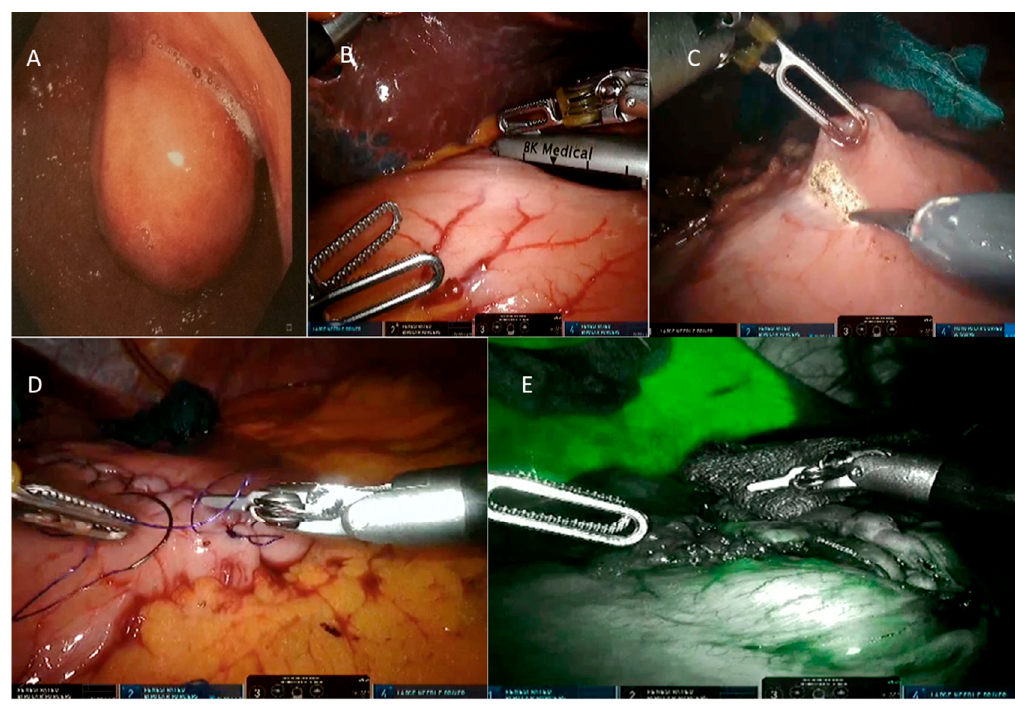
Figure 6. Endoscopic view of luminal lesion and robotic approach.